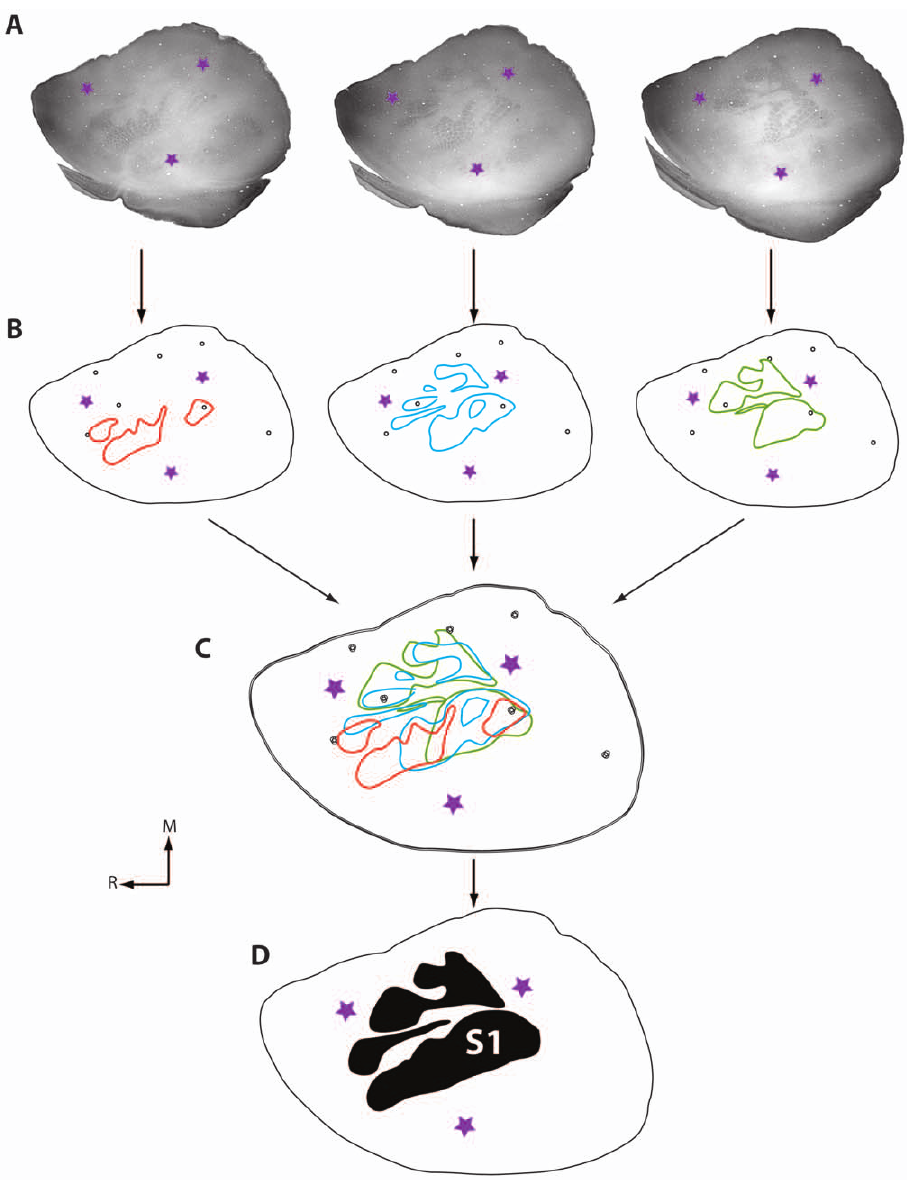
Figure 4. Reconstruction of architectonic borders. A) Photomicrographs are consecutive sections of CO-stained tissue each containing portions of the architectonic boundaries of the primary somatosensory area. Blood vessels appear as small white circles, and the primary sensory areas are visible as more darkly staining areas. The purple stars in all figures represent location of fluorescent probes placed in the brain during electrophysiological recording experiments and marked on the digital photograph of the brain, along with recording sites. By aligning these probes with digital images containing electrophysiological recordings, functional maps of S1 can be accurately matched to cortical architecture. B) The outer boundary of the cortical sheet and blood vessels are drawn along with portions of S1 (red, blue and green lines) that are visible in each section. C) By aligning blood vessels, data from all sections are superimposed onto a single section, and then a single comprehensive reconstruction of architectonic boundaries is drawn (D). In all sections, medial is to the top and rostral is to the left.